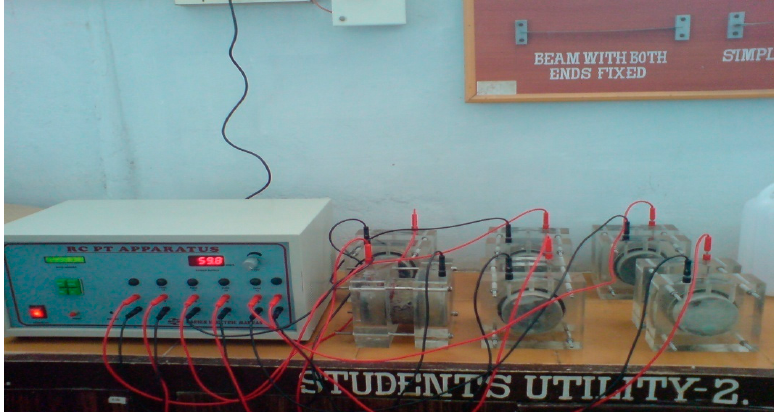
Figure 3. Specimens under RCPT testing. Table 2. RCPT ratings (as per ASTM C1202).